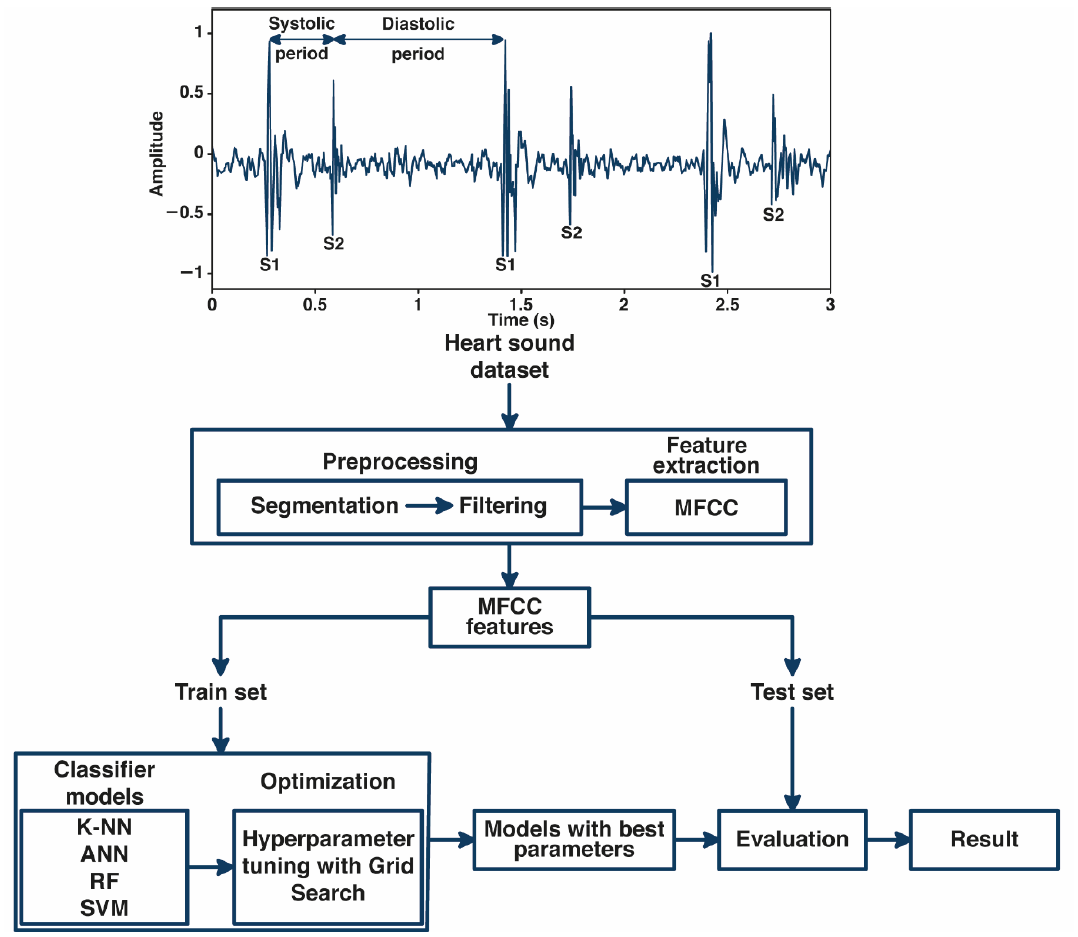
Figure 1. General block diagram system.